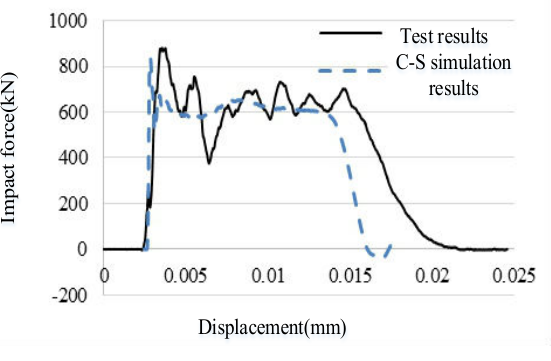
Figure 13. Impact-time history curve of C-S constitutive model